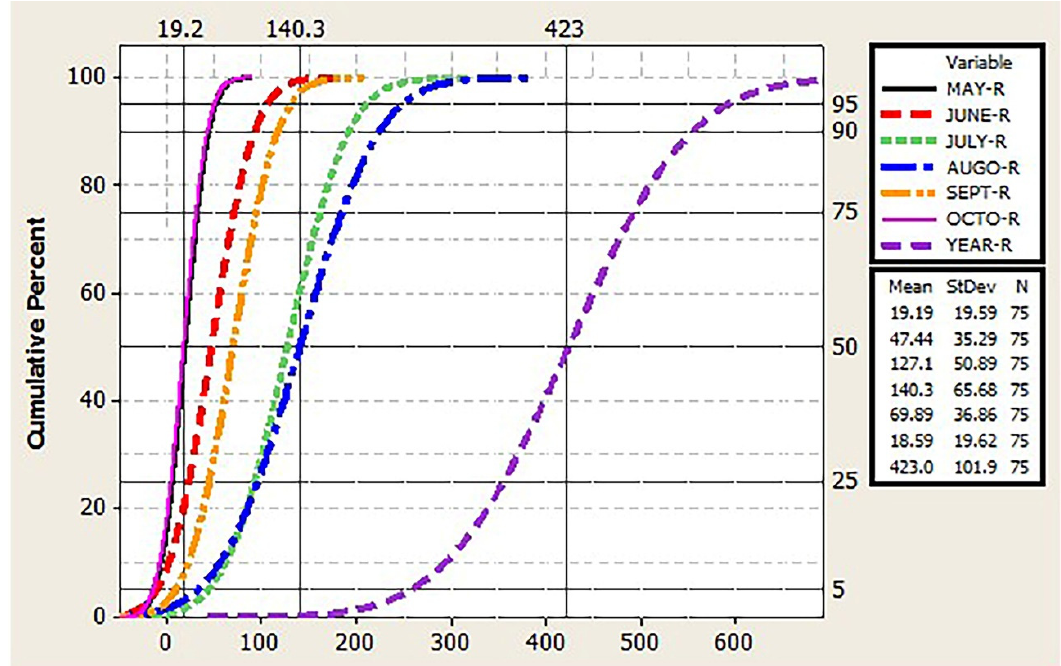
Figure 2. Monthly precipitations cumulative percent histogram.